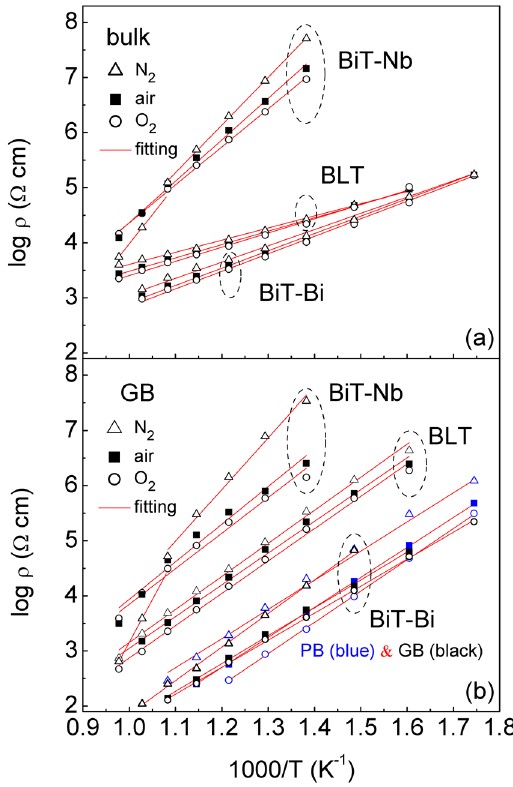
Figure 8. ( a ) ρ bu lk and ( b ) ρ GB Arrhenius plots for the air-, O 2 - and N 2 -processed BiT-Bi, BLT and BiT-Nb